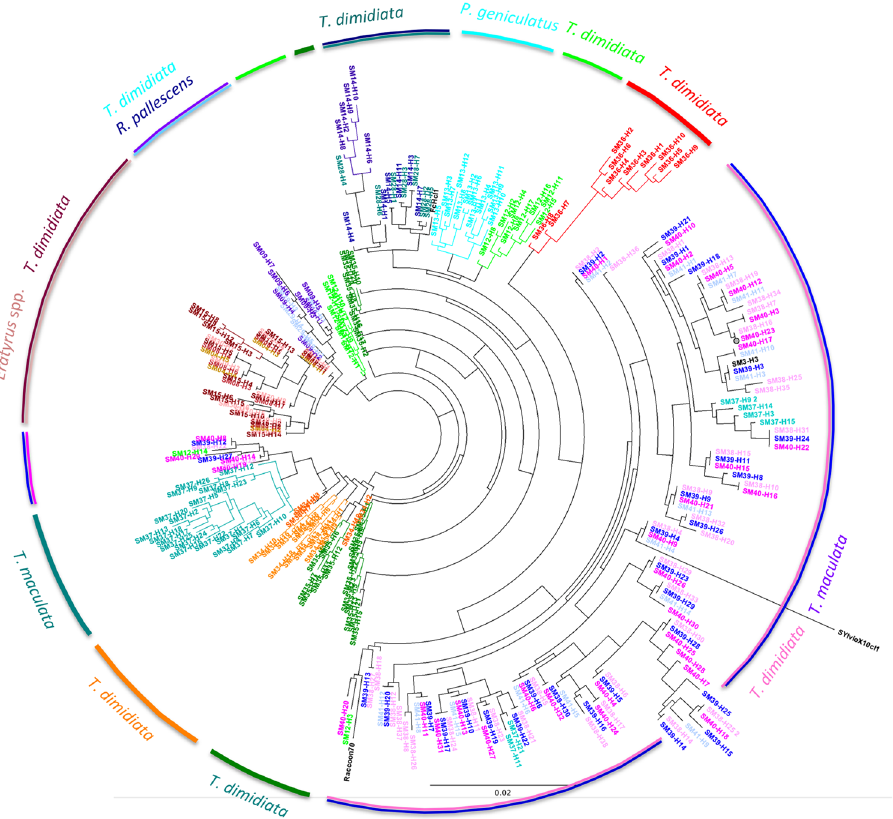
Figure 4. Phylogenetic analysis of T. cruzi mini-exon diversity. A total of 287 mini-exon sequences are shown that are color-coded for each individual bug analyzed. The corresponding triatomine species are indicated in the outer ring. Reference sequences from TcIa (Raccoon70 strain), TcIb (FcHcl1 strain) and TcId (SylvioX10 strain) are also included in the